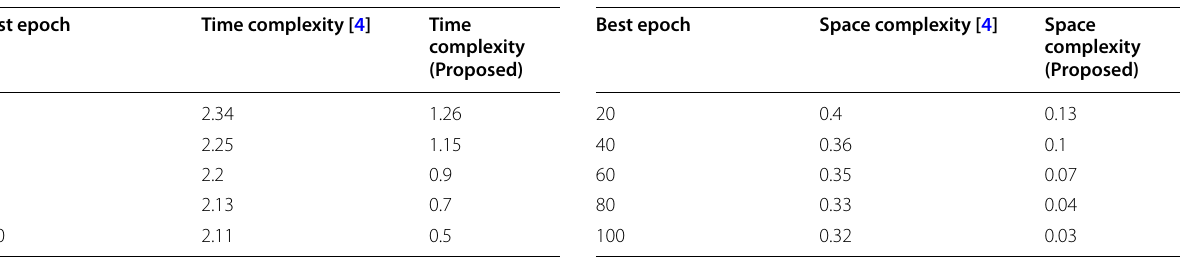
Table 6 Time complexities of IBFA Table 7 Space complexity